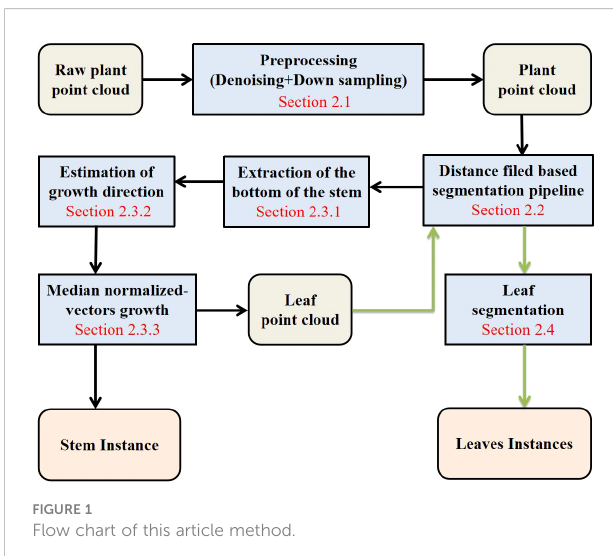
FIGURE 1 Flow chart of this article